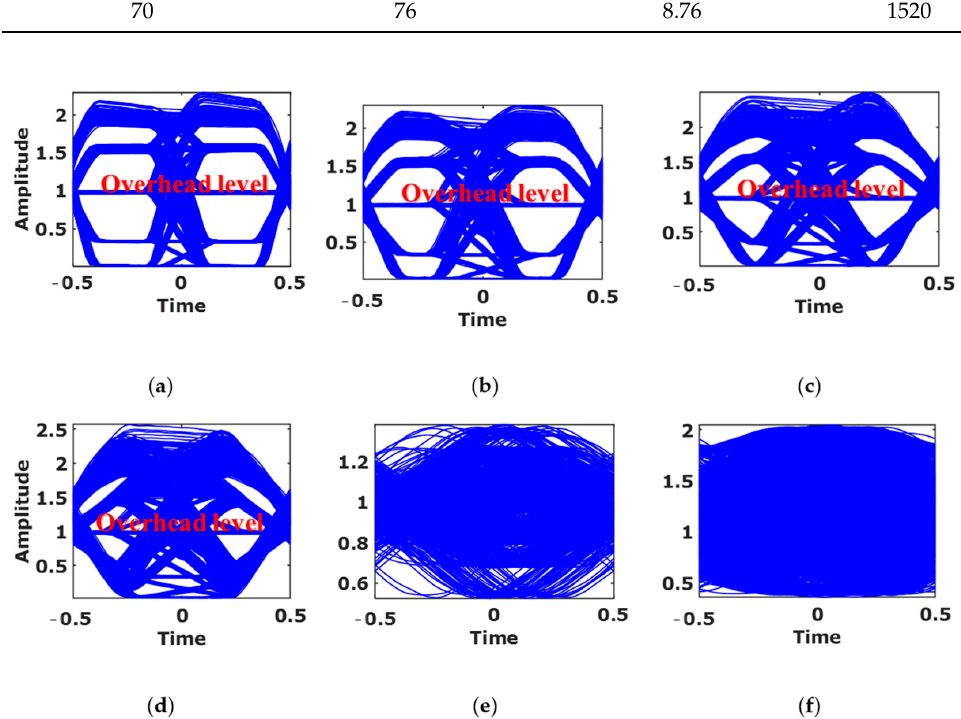
Figure 8. Examples of the captured eye diagrams of the CIS received signal for CP 4-PAM with f Tx of: ( a ) 220 Hz, ( b ) 320 Hz, ( c ) 420 Hz, ( d ) 520 Hz, ( e ) 1120 Hz, and ( f ) 1520